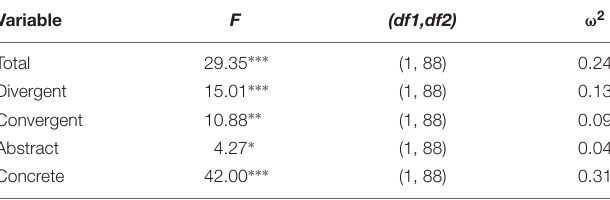
TABLE 4 | Interaction effect of time × group in post-test.